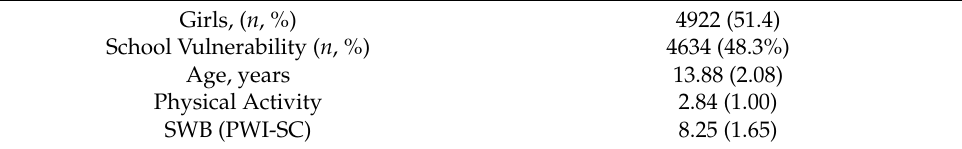
Table 1. Participants’ Characteristics ( n = 9572).